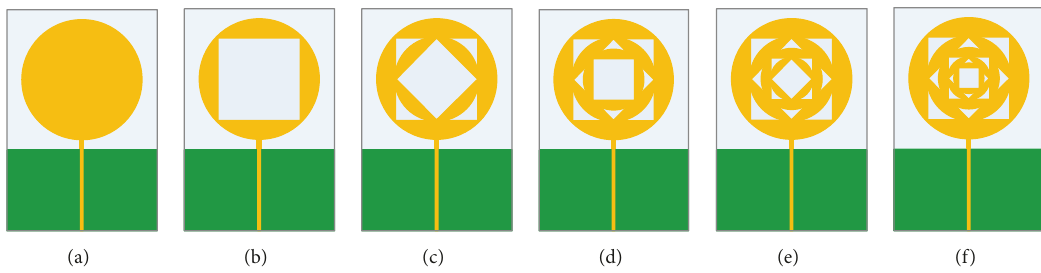
Figure 3: Proposed antenna in the stepwise iteration stages: (a) 0th iteration, (b) 1st iteration, (c) 2nd iteration, (d) 3rd iteration, (e) 4th iteration, and (f) 5th